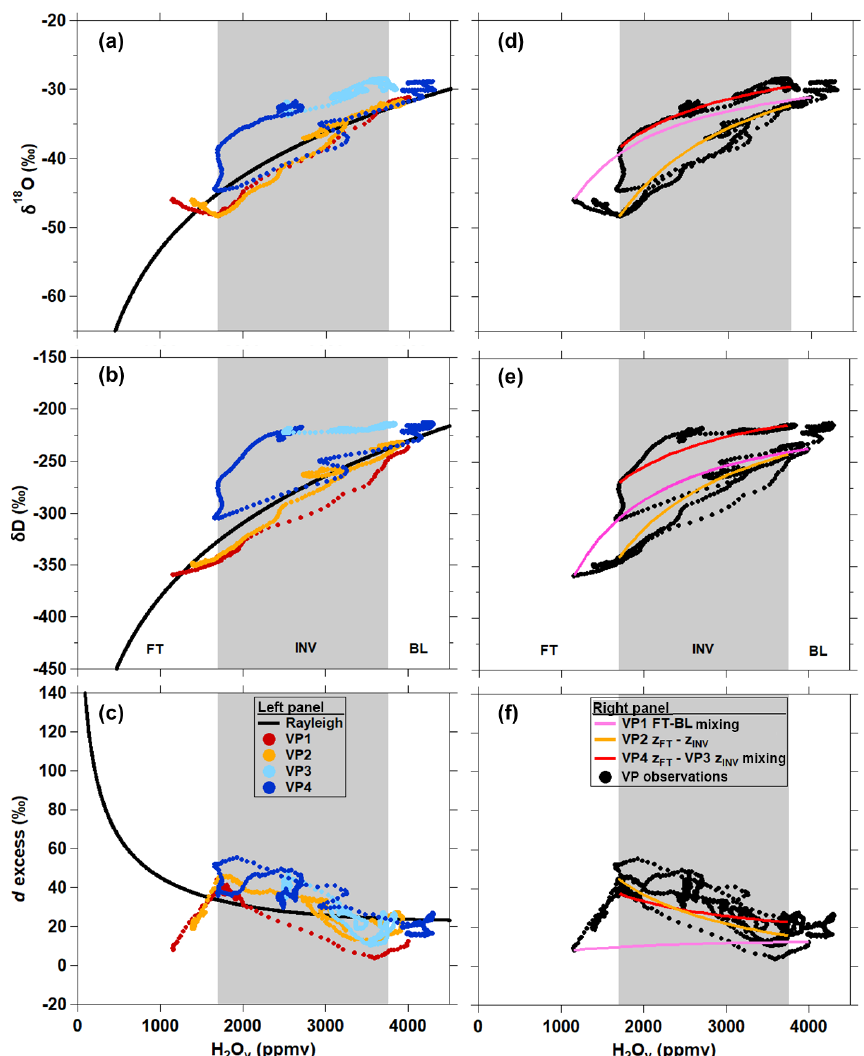
Figure 12. Comparison of vertical profile δ 18 O (a, d) , δ D (b, e) , and d -excess (c, f) measurements to Rayleigh theory (a, b, c) and mixing (d, e, f) curves for DBL (MAR18). Individual VP descents are indicated by the differently colored points. The bounds of the inversion layer (INV), indicated by grey shading, are defined by the average H 2 O v mole fractions observed at z INV and z FT